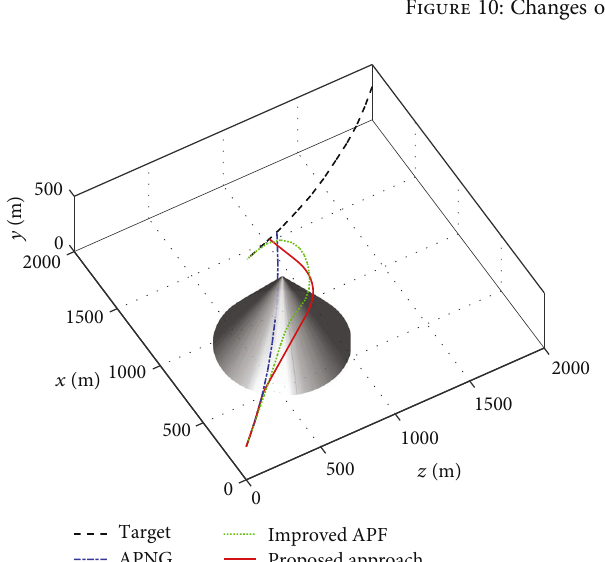
Figure 10: Changes of control inputs in case 1.